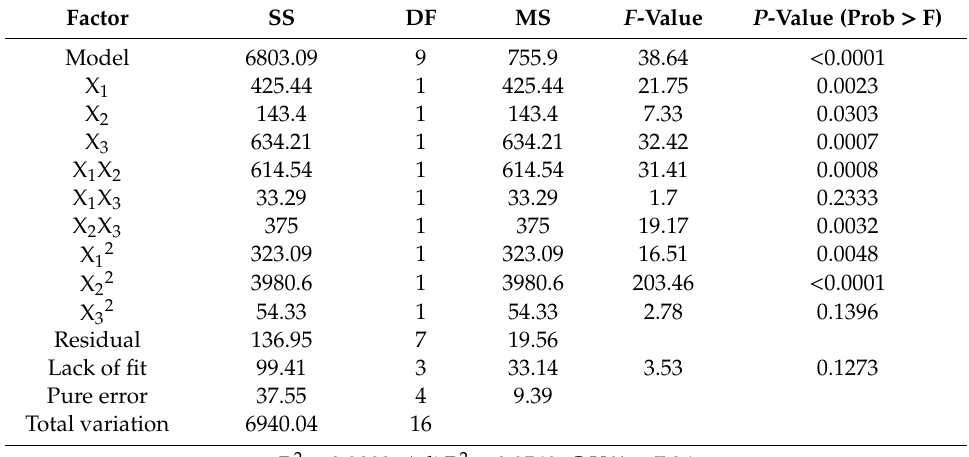
Table 2. Variance analysis of mathematical regression